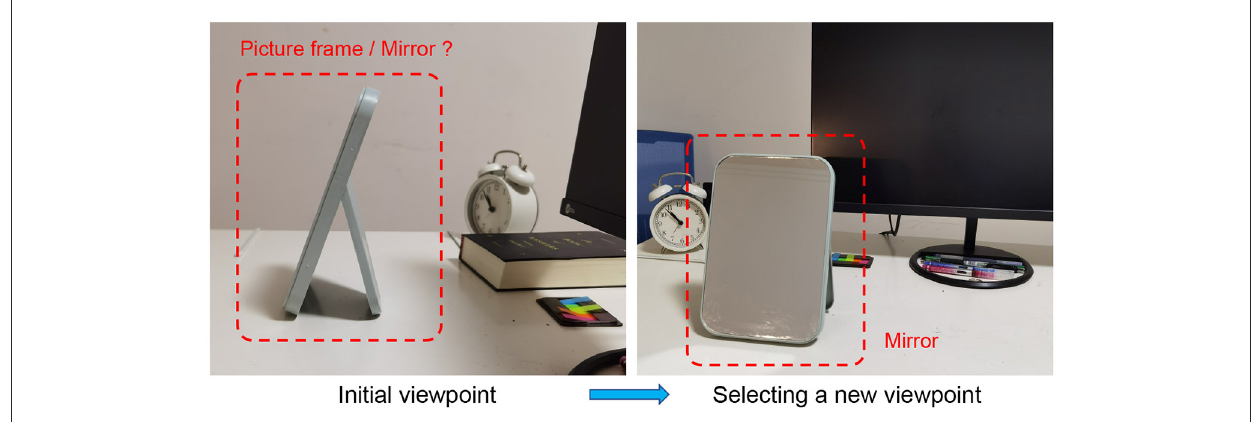
FIGURE1 An example illustrating the active preception process of people.